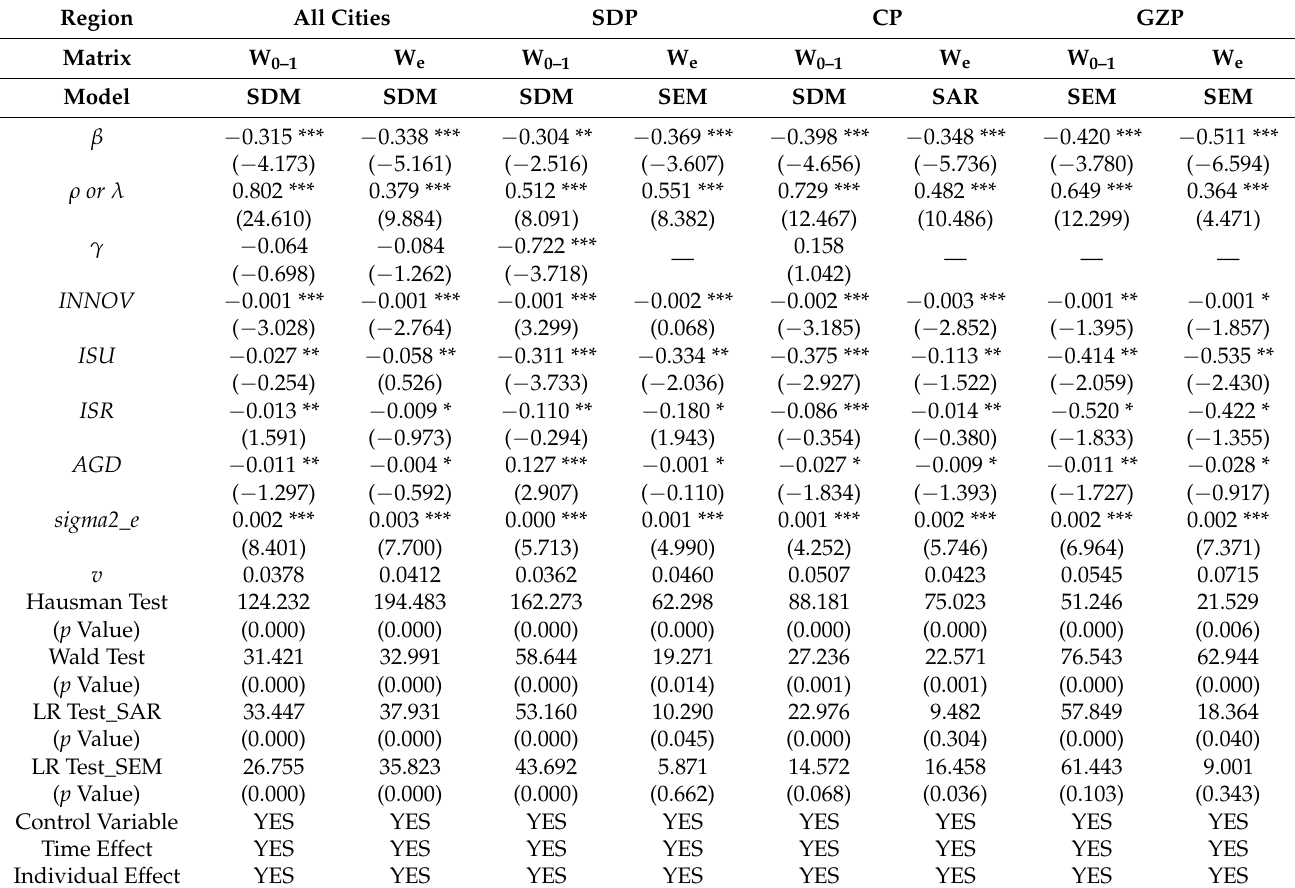
Table 8. Robustness tests based on different spatial weight